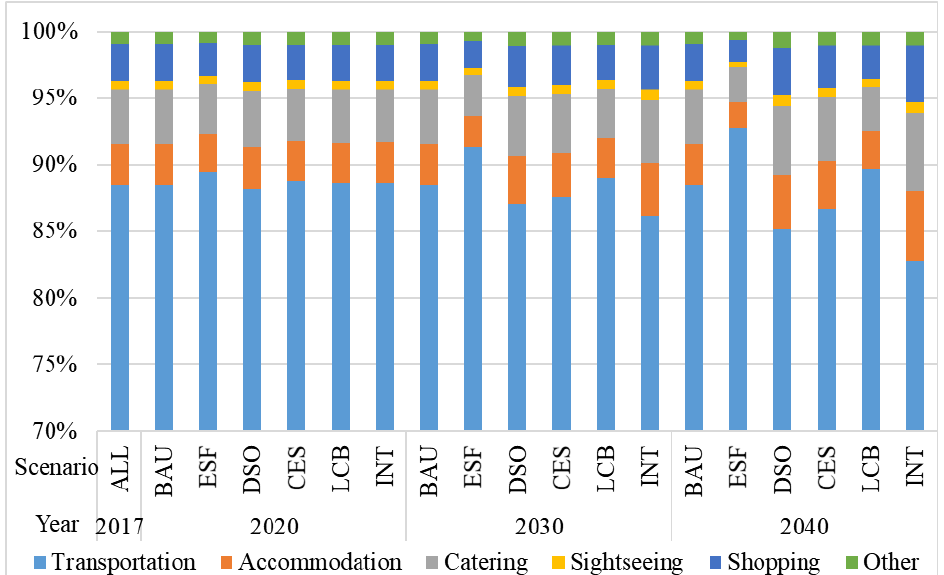
Figure 4. Percentage of total consumption in the energy consumption sector under the various scenarios. Int. J. Environ. Res. Public Health 2021 , 18 , x FOR PEER REVIEW